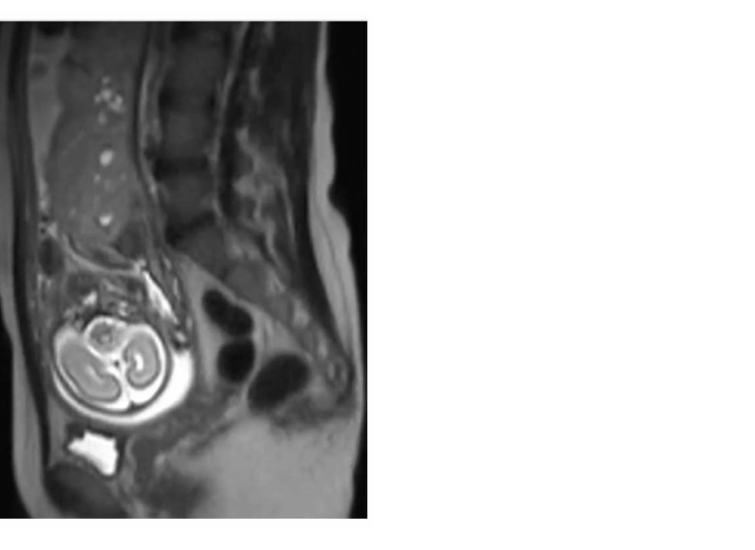
Figure 3. MRI scan showing placentomegaly, with no signs for abnormal adherence and the fetus